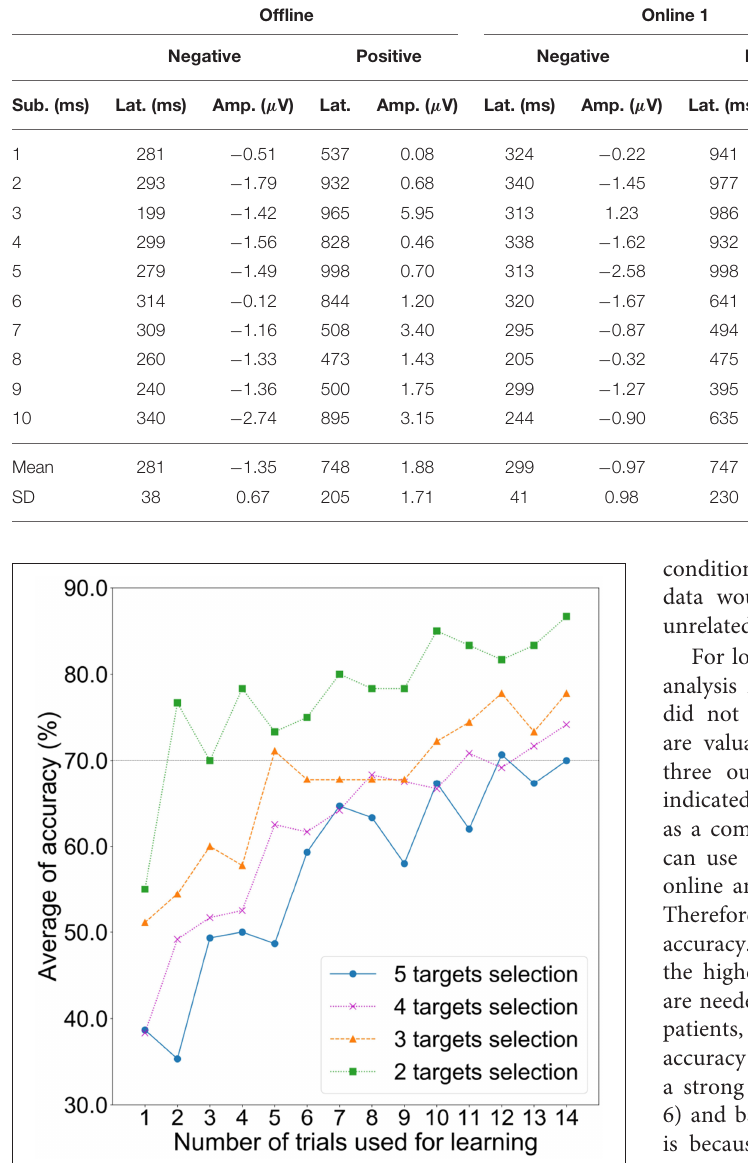
FIGURE 6 | Average detection accuracies based on LOTOCV for increasing the number of learning trials with two, three, four, and five commands.